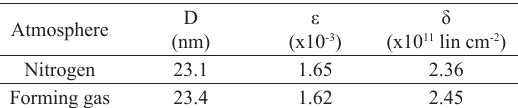
Table 2. Crystallite size, stress, and dislocation density of ATO thin films annealed at 425°C with different atmospheres. Atmosphere